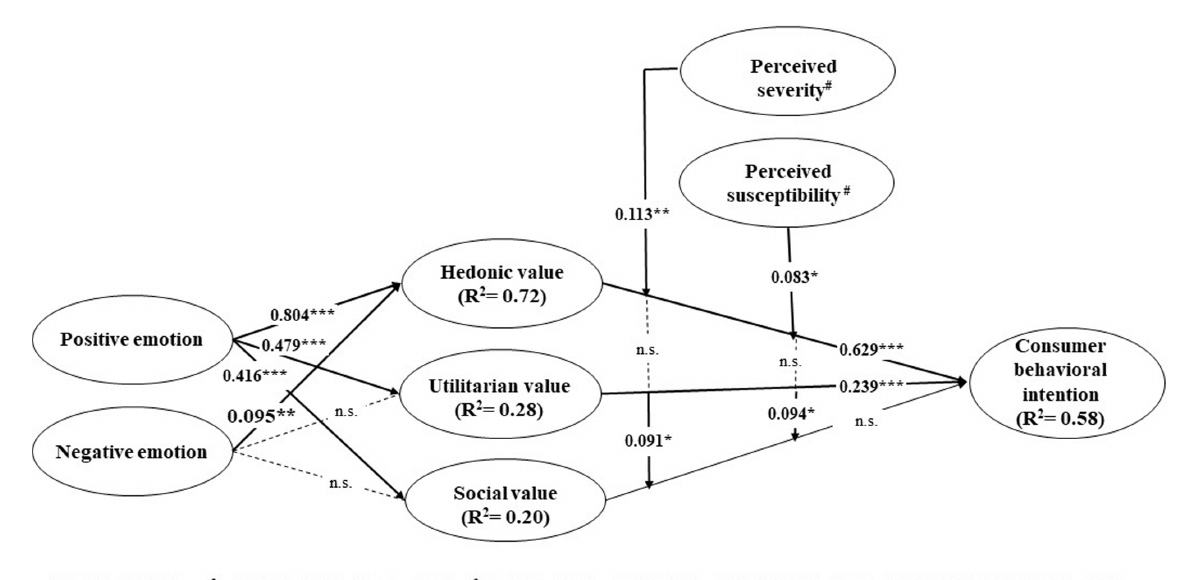
FIGURE 2 Result of research model. *** p -value <0.001; ** p -value <0.01; * p -value <0.05. n.s. not statistically significant. Significant correlation values at the value of p < 0.05 were highlighted in bold. # Model fits for Model 2 and 3 of perceived severity and perceived susceptibility respectively are reported in Table